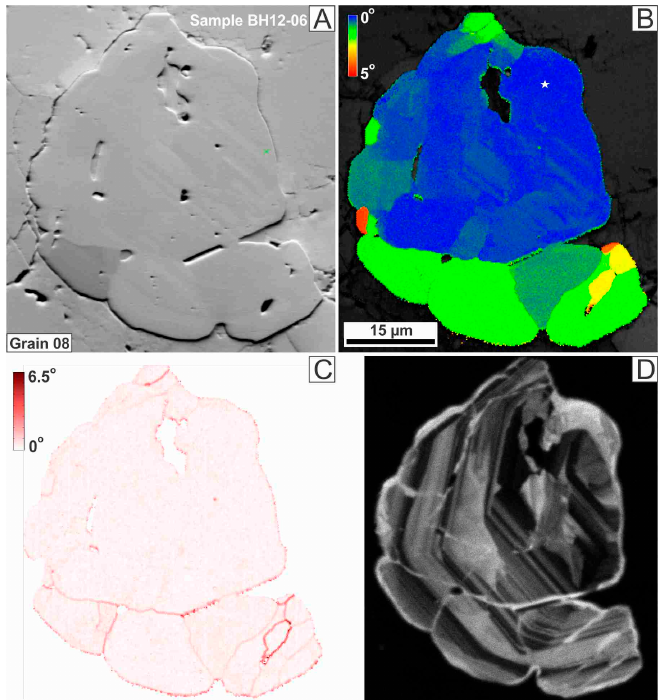
Figure 10. Data on the grain 08, sample BH12-06. ( A ) Orientation contrast image. ( B ) Cumulative misorientation EBSD map, showing the orientation of every data point with respect to a user-selected reference point (white star). Misorientation varies from 0 (blue) to 5° (red). ( C ) Local misorientation EBSD map, showing misorientation of every pixel with respect to its neighbors. ( D ) Panchromatic CL image.